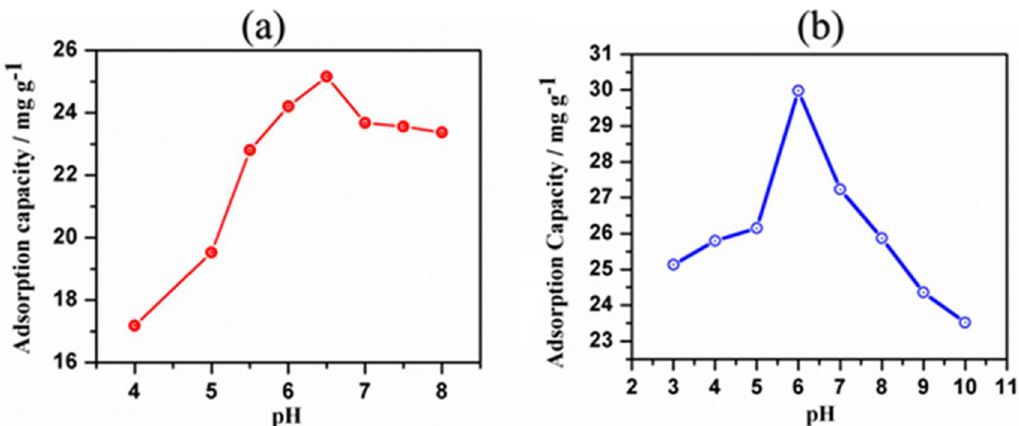
J. Compos. Sci. 2020 , 4 , x FOR PEER REVIEW Figure 7. Plot of adsorption capacity of ( a ) Ni 2 + and ( b ) Cd 2 + by hematite nanoparticles vs. pH. Figure 7. Plot of adsorption capacity of ( a ) Ni 2+ and ( b ) Cd 2+ by hematite nanoparticles vs. pH.